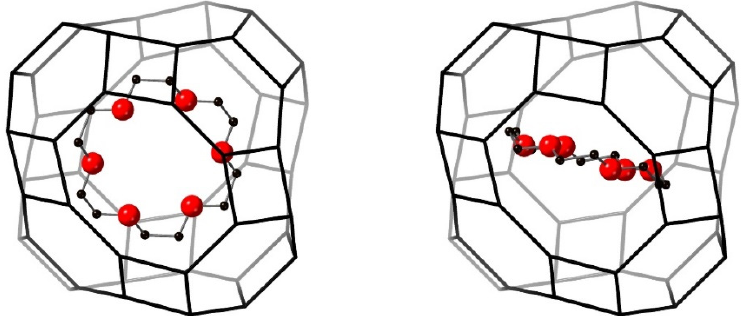
Figure 4. Location of the C and O sites of the 18C6 oxyethylene chain in the α -cage of the filled zeolite RHO. An example of two 18C6 orientations in the cage are shown. The framework is shown as a stick model, the carbon sites as black spheres and the oxygen sites as red spheres.